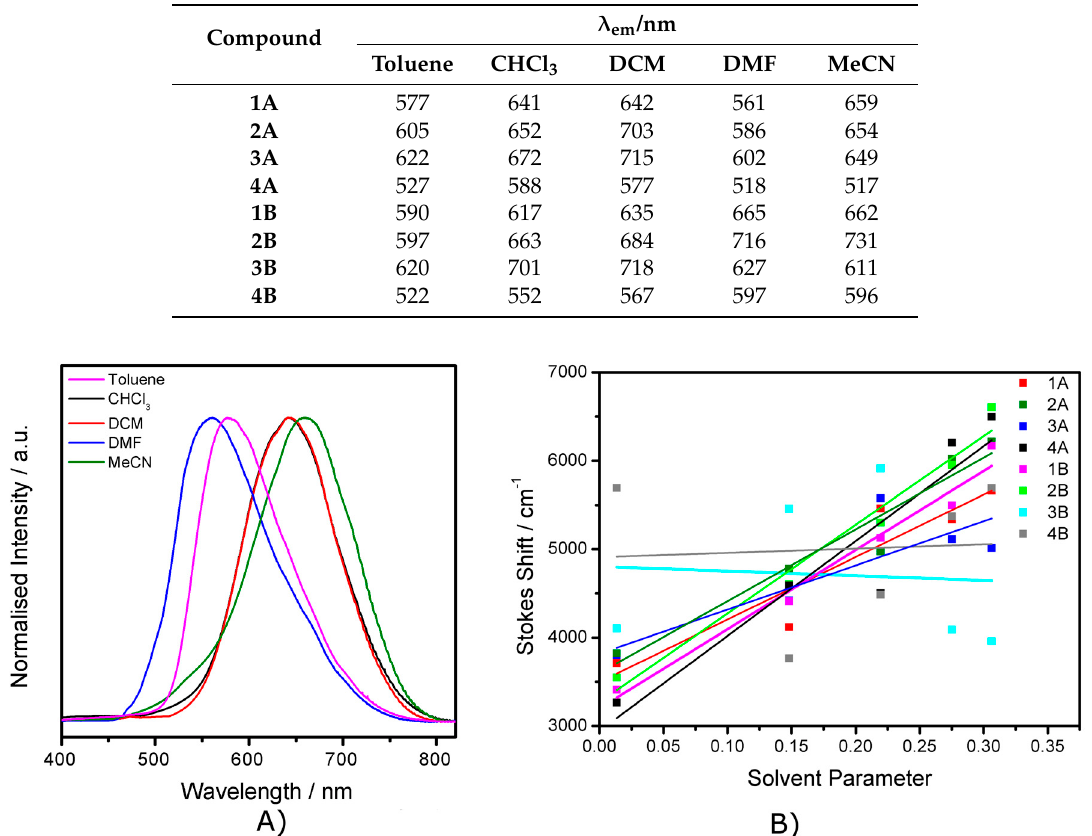
Figure 9. ( A ) Emission spectra for 1A measured in a range of solvents and ( B ) Lippert-Mataga plots for all the compounds based on experimental absorption and emission data.